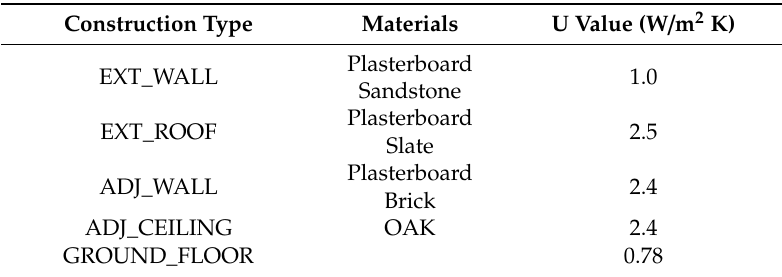
Table 2. Initial heat transfer co-e ffi cient of TRNBuild constructions.